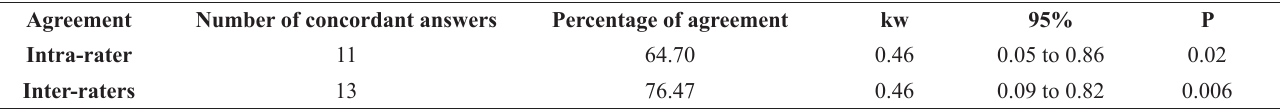
Table 7 - Inter-and intra-rater comparing the scores of four DMA (high, moderate, mild, and minimum) of 17 participants Agreement